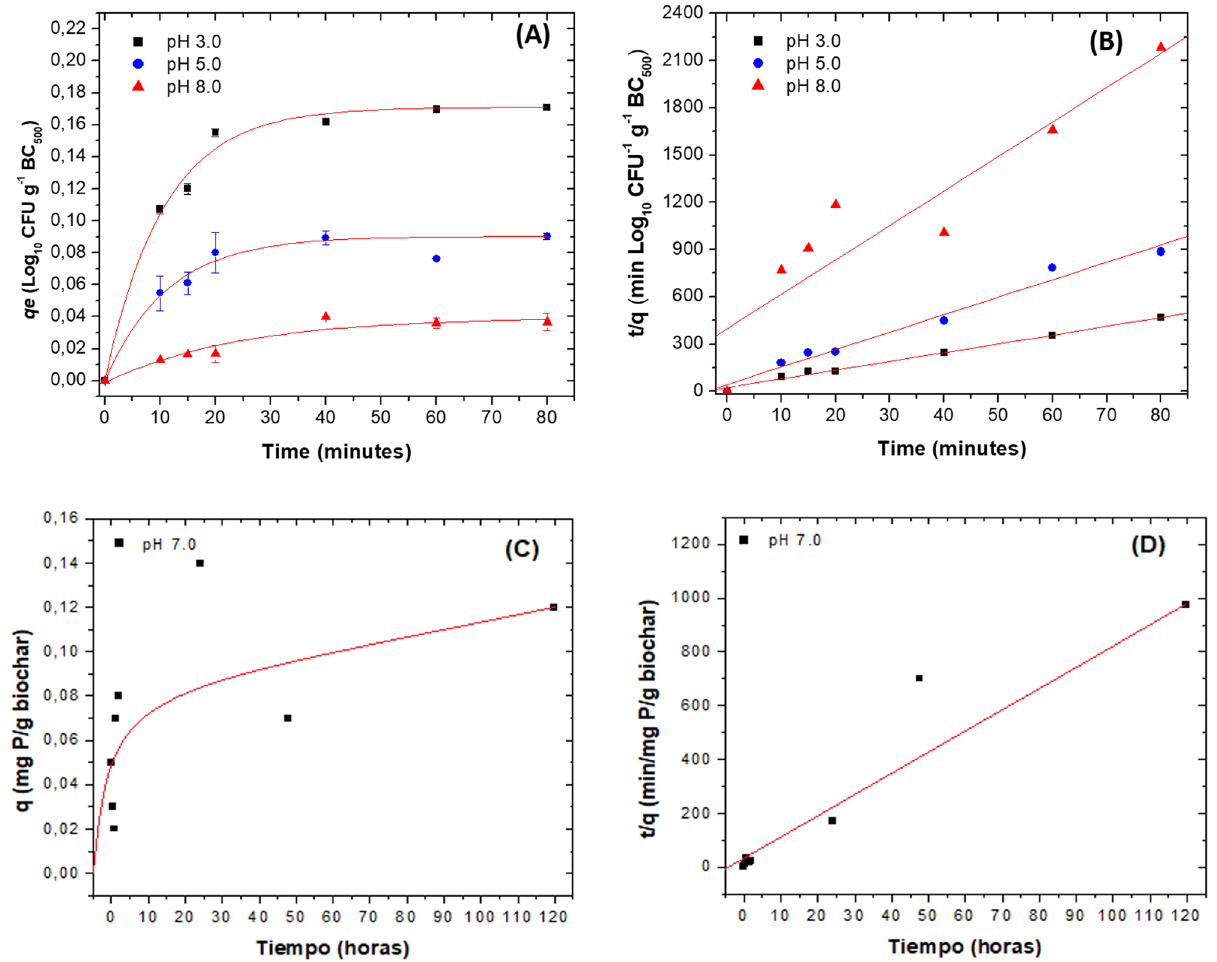
Figure 3. Adsorption studies. ( A ) qe value as a function of time at different pH for PSB. ( B ) Pseudo-second- order model for PSBs. ( C ) qe value as a function of time at pH 7.0 for orthophosphate ions. ( D ) Pseudo-second- order model for orthophosphate ions. Results are the average of three replicates with their respective